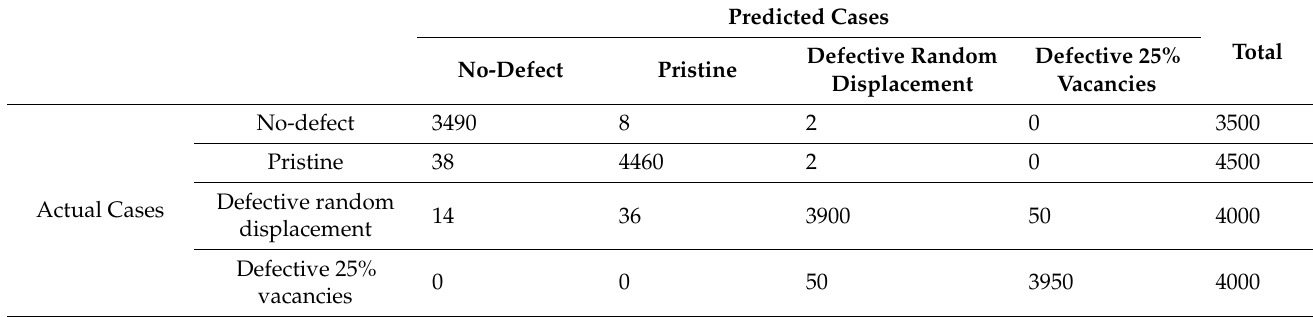
Table 4. Exper-2 confusion matrix for Dns-Net + regression without transfer